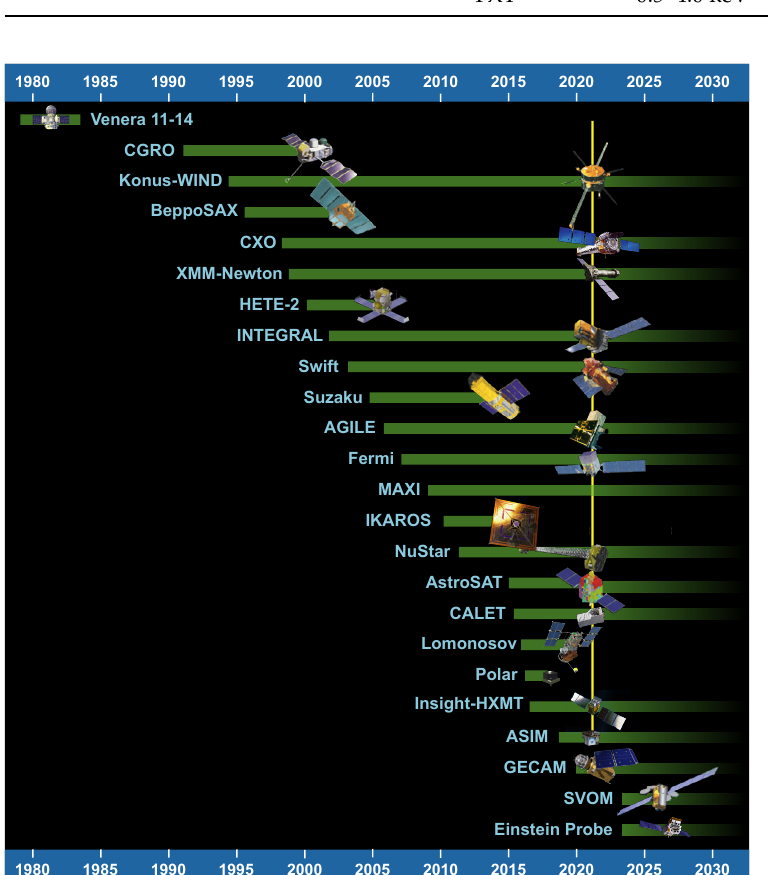
Figure 1. Main past, present, and future space-based missions for GRB science. Based on Figure 1 from [23] with permission from